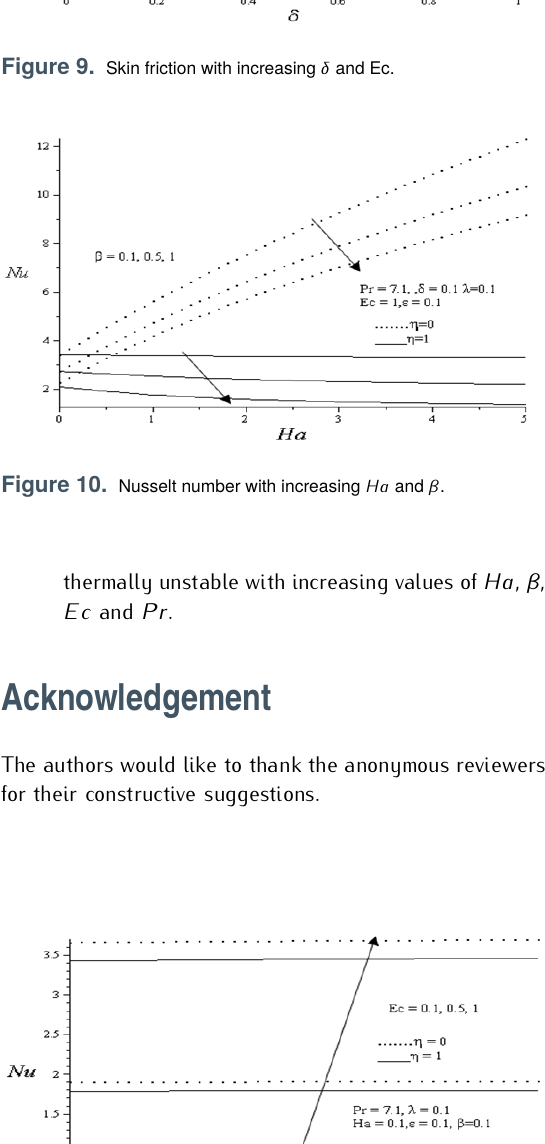
Figure 11. Nusselt number with increasing δ and Ec